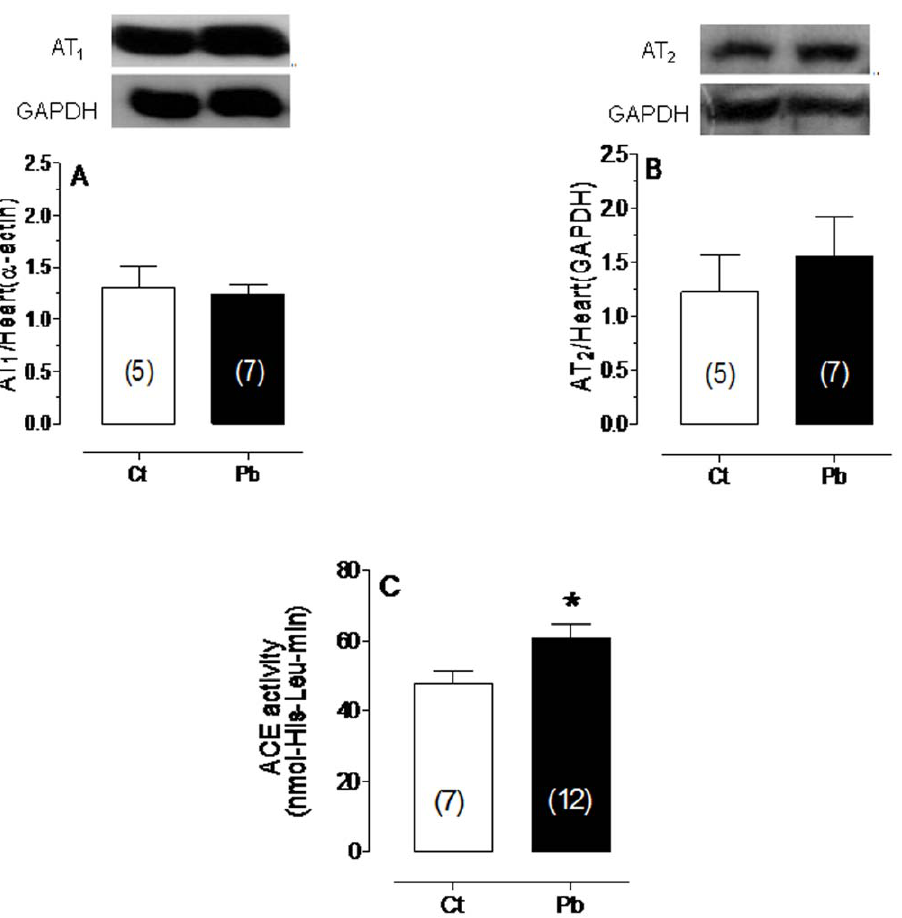
Figure 2. Effects of lead on protein expression and ACE activity. Effects of lead exposure on the protein expression of the (A) AT1 and (B) AT2 receptors and on (C) ACE activity. *p , 0.05 compared with untreated controls. The number of animals used is indicated in parentheses.